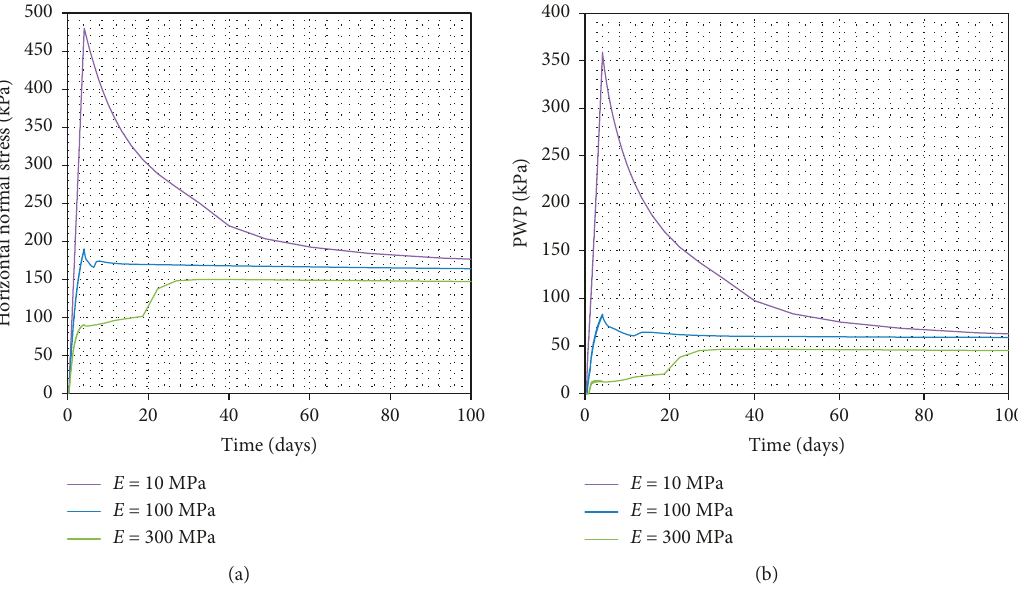
Figure 12: Evolution of the (a) horizontal total stress σ h and (b) PWP u w at midheight of the barricade for three different values of the backfill modulus (see the details in Table 1, Case 7).